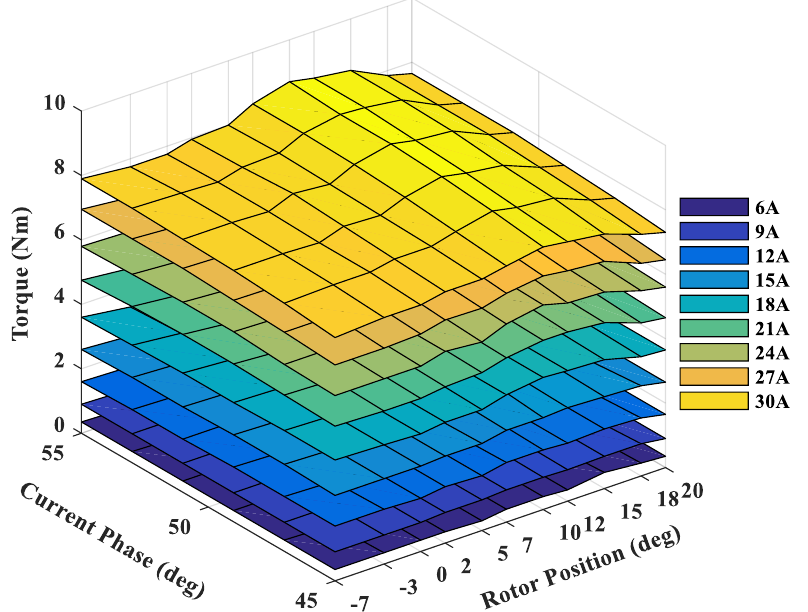
Figure 16. Measured torque vs. current phases and rotor positions.